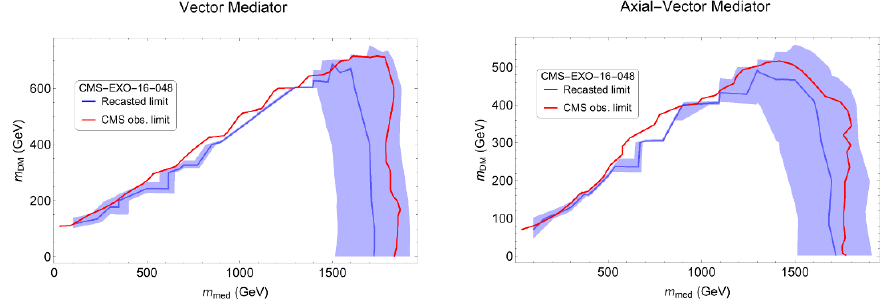
Figure 12 . The validation plots for [15]. The color-coding is the same as in (cid:12)gure 11.